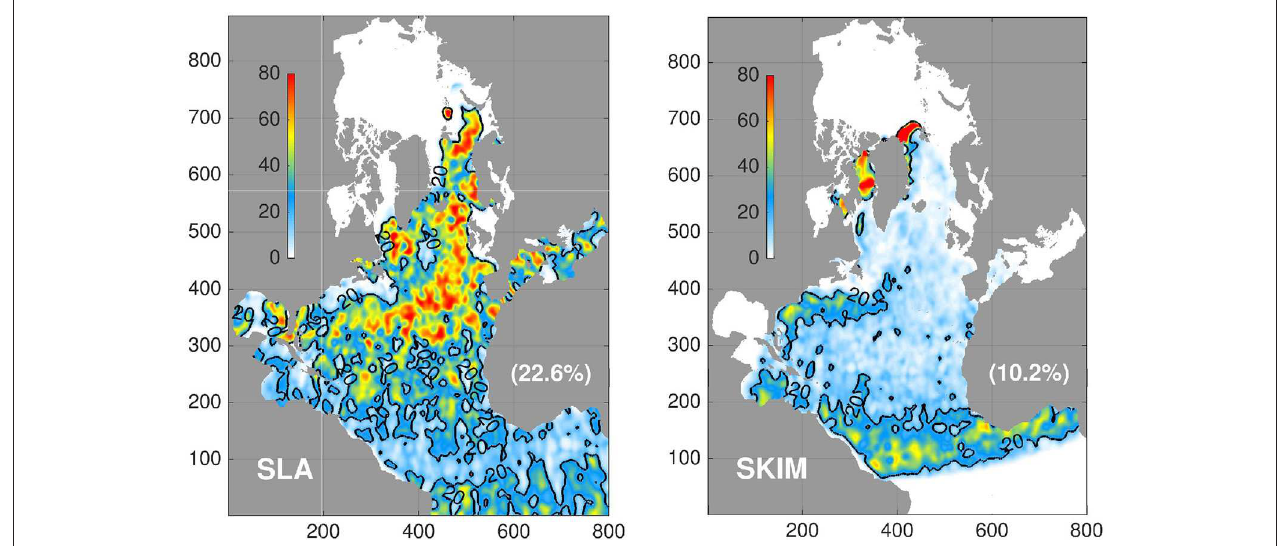
FIGURE 10 | Relative DFS impact factor projected in model coordinates in the TOPAZ system. The area-averaged impact fraction is indicated in parenthesis. The chart is presented in model native coordinates and shows the whole model domain.